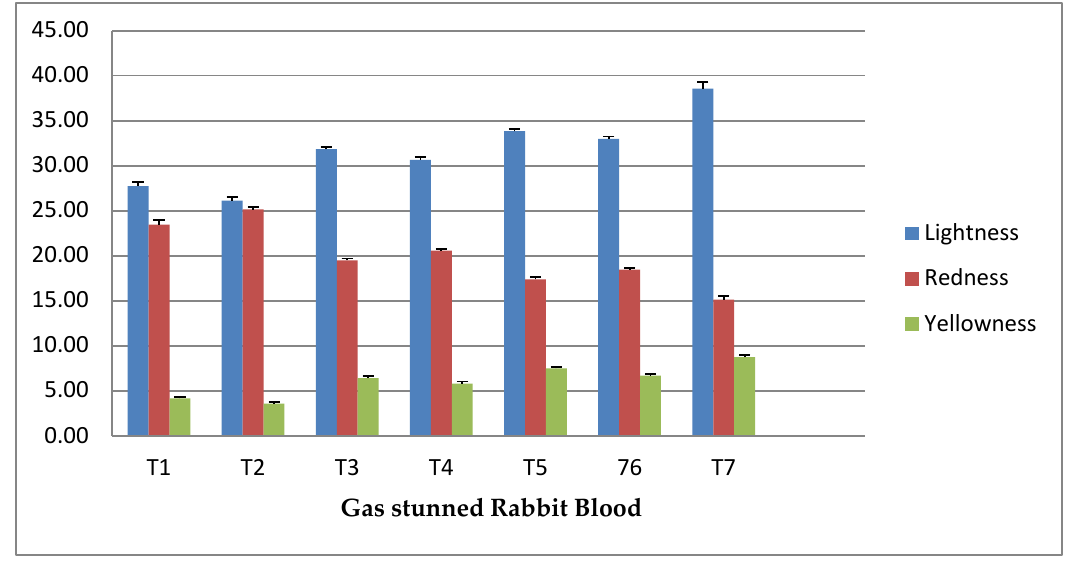
Figure 3. Effect of different gas stunning conditions on Rabbits Blood. T1 = CO 2 -85%, T2 = CO 2 -90%, T3 = Ar-85%, T4 = Ar-90%, T5 = N 2 -96%, T6 = N 2 -98% and T7 = Halal Method.